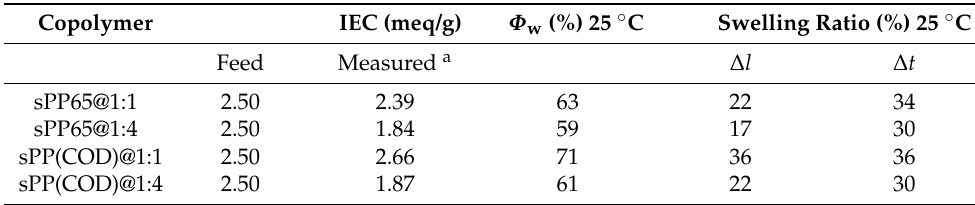
Table 2. Measured ion exchange capacity, water uptake ( Φ w ), and in-plane ( ∆ l ) and through-plane ( ∆ t ) swelling ratios for block copolymers selected for membrane casting.